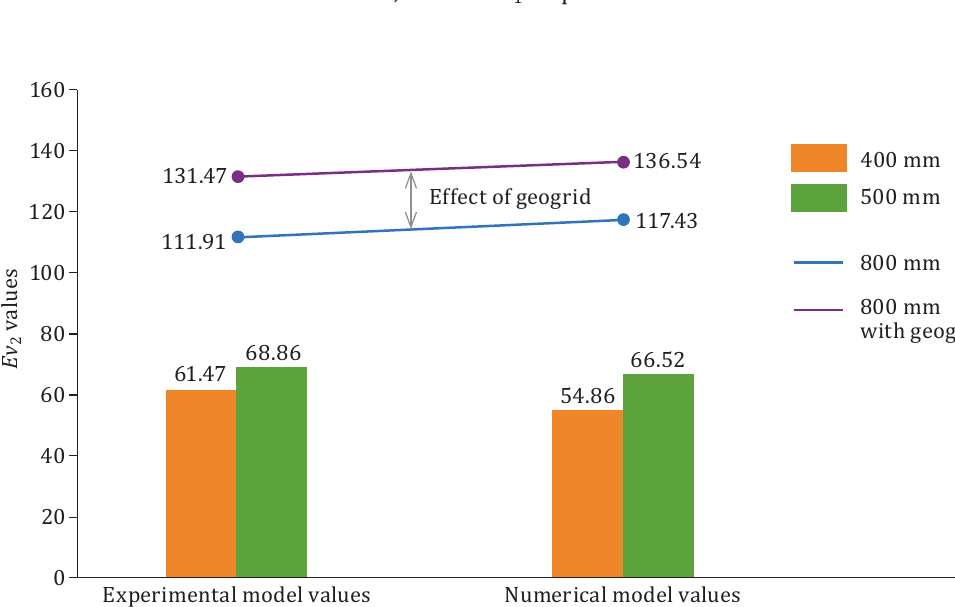
Figure 9. Comparison of experimental and numerical studies for Ev 2 values Experimental model values Numerical